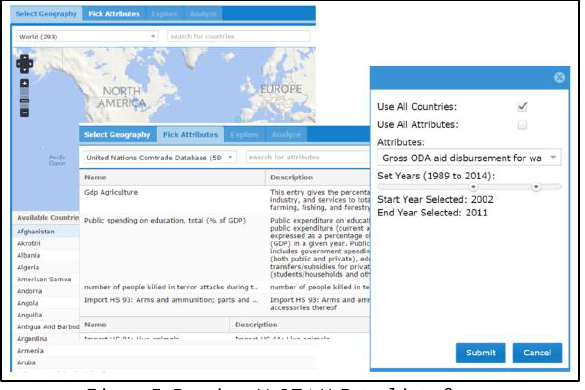
Figure 5. Previous WSTAMP tool interface